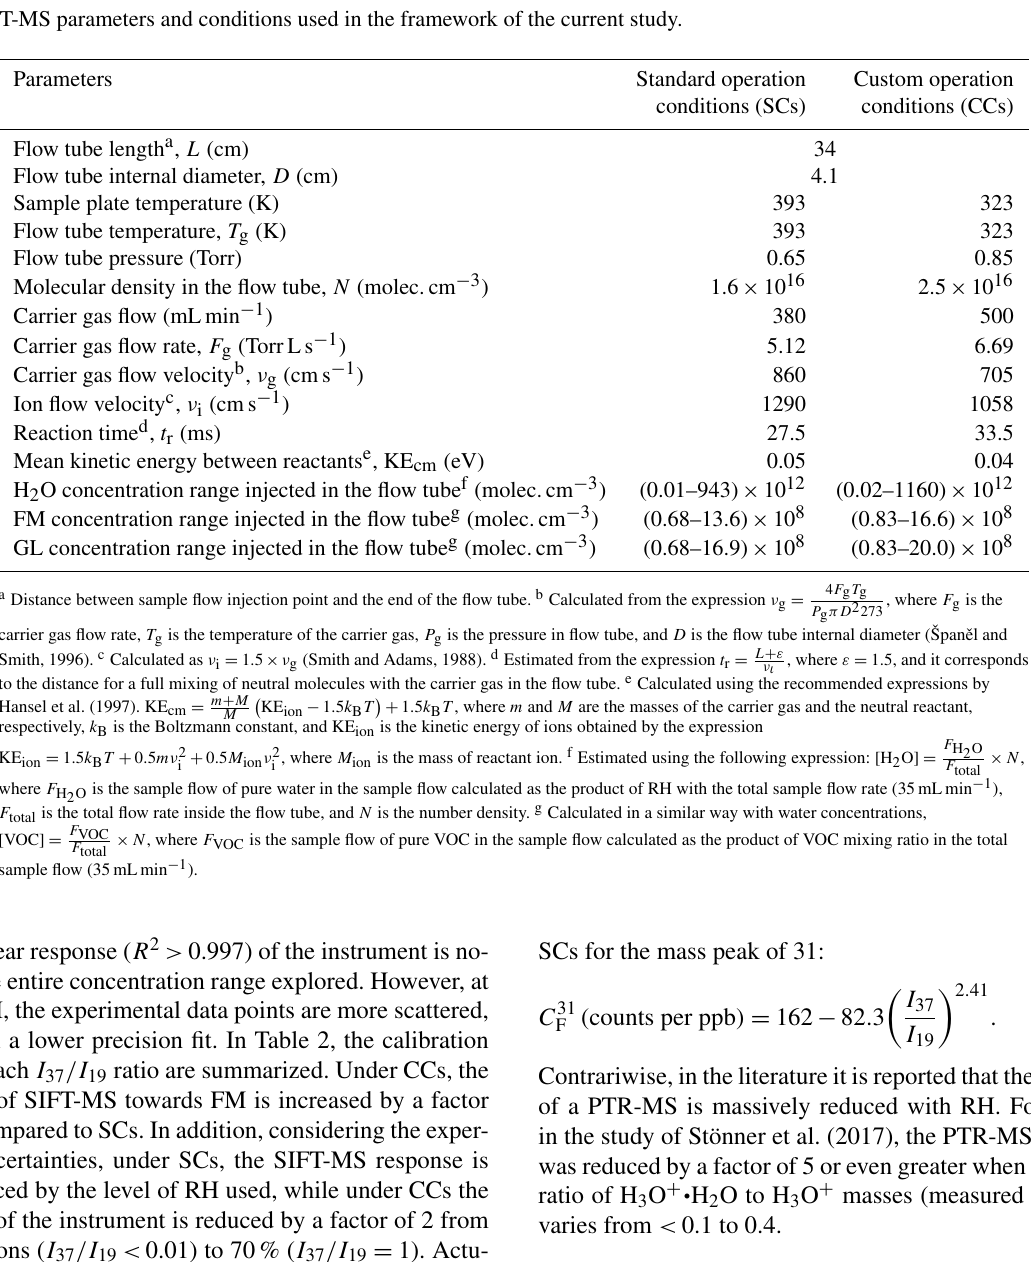
Table 1. SIFT-MS parameters and conditions used in the framework of the current study. Parameters Standard operation Custom operation